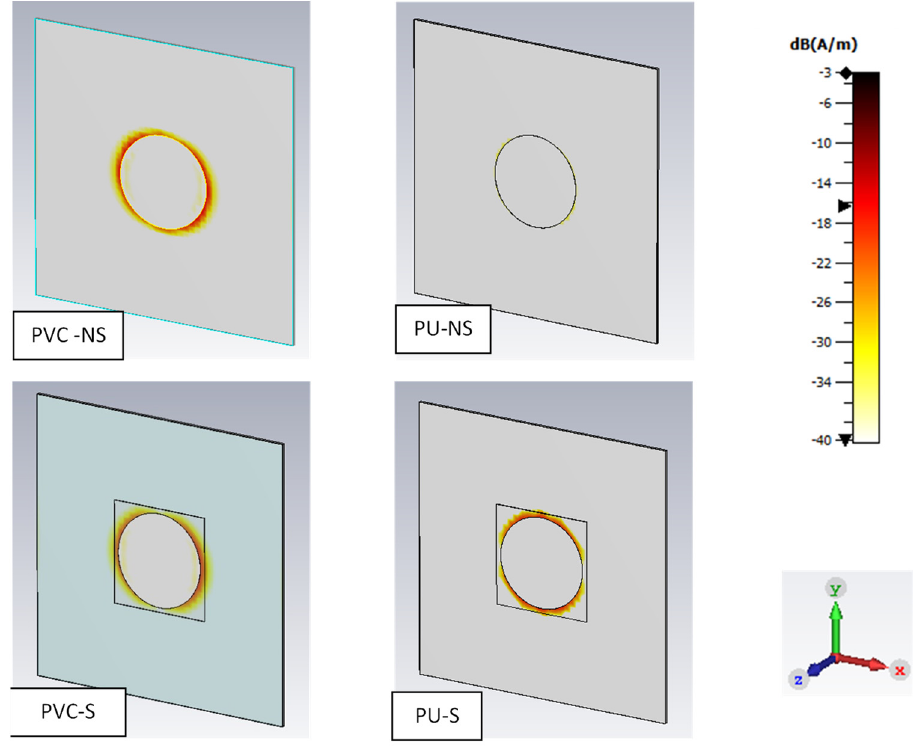
Figure 11. Simulated surface current distribution on each system at resonant frequency.